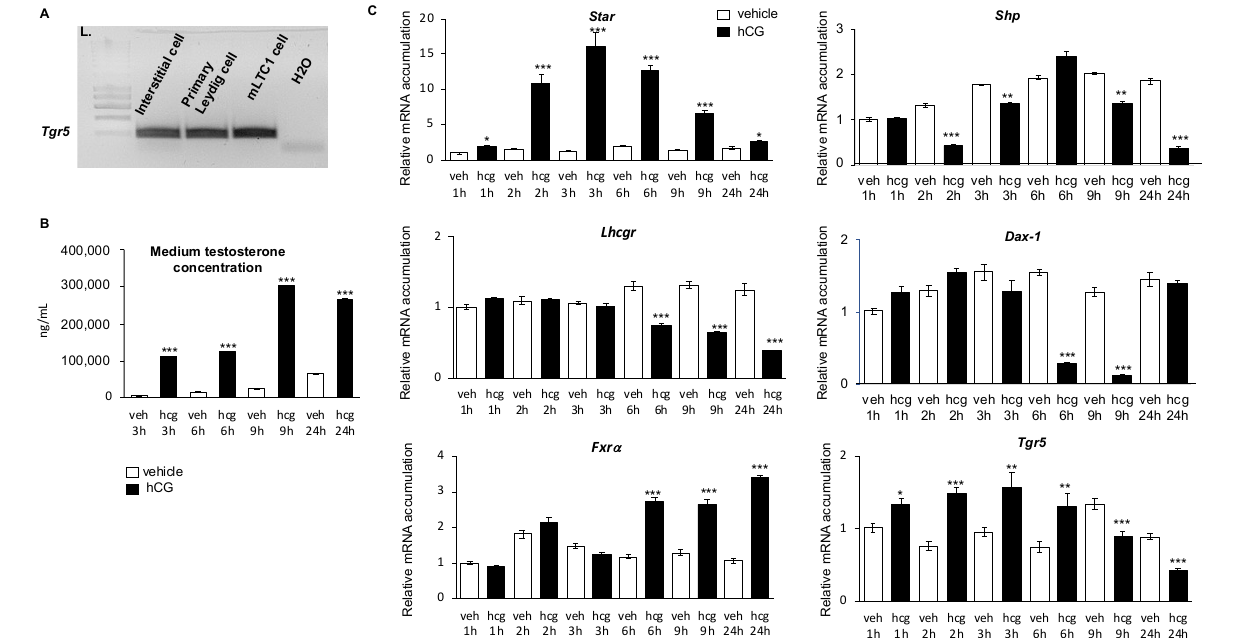
Figure 1. Tgr5 was expressed in mouse testis. ( A ) Detection of Tgr5 mRNA in mouse testicular interstitial compartment, in mouse primary Leydig cells, and in the mLTC1 cell line determined by RT-PCR analysis. ( B ) Testosterone concentrations determined in the culture medium of mLTC1 cells treated with vehicle (NaCl 0.9%) or hCG (25 nM) for 3, 6, 9, or 24 h. ( C ) Relative Star, Shp, Lhcgr, Dax-1, Fxr α , and Tgr5 mRNA accumulations normalized to β -actin in mLTC1 cells treated with vehicle (NaCl 0.9%) or hCG (25 nM) for 1, 2, 3, 6, 9, or 24 h. In all panels, n = 9 to 12. Data are expressed as the means ± SEM. Statistical analysis: *, p < 0.05; **, p < 0.01; ***, p < 0.001 versus vehicle-treated cells for the same timing. Leydig cell homeostasis is regulated by the hypothalamus–pituitary axis through LH/CG (Luteinizing hormone/choriogonadotropin) signaling [11]. The present data